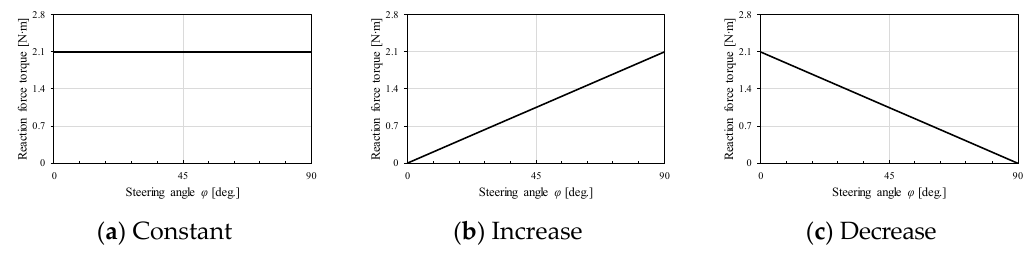
Figure 3. Setting of the torque for the reaction force actuator.